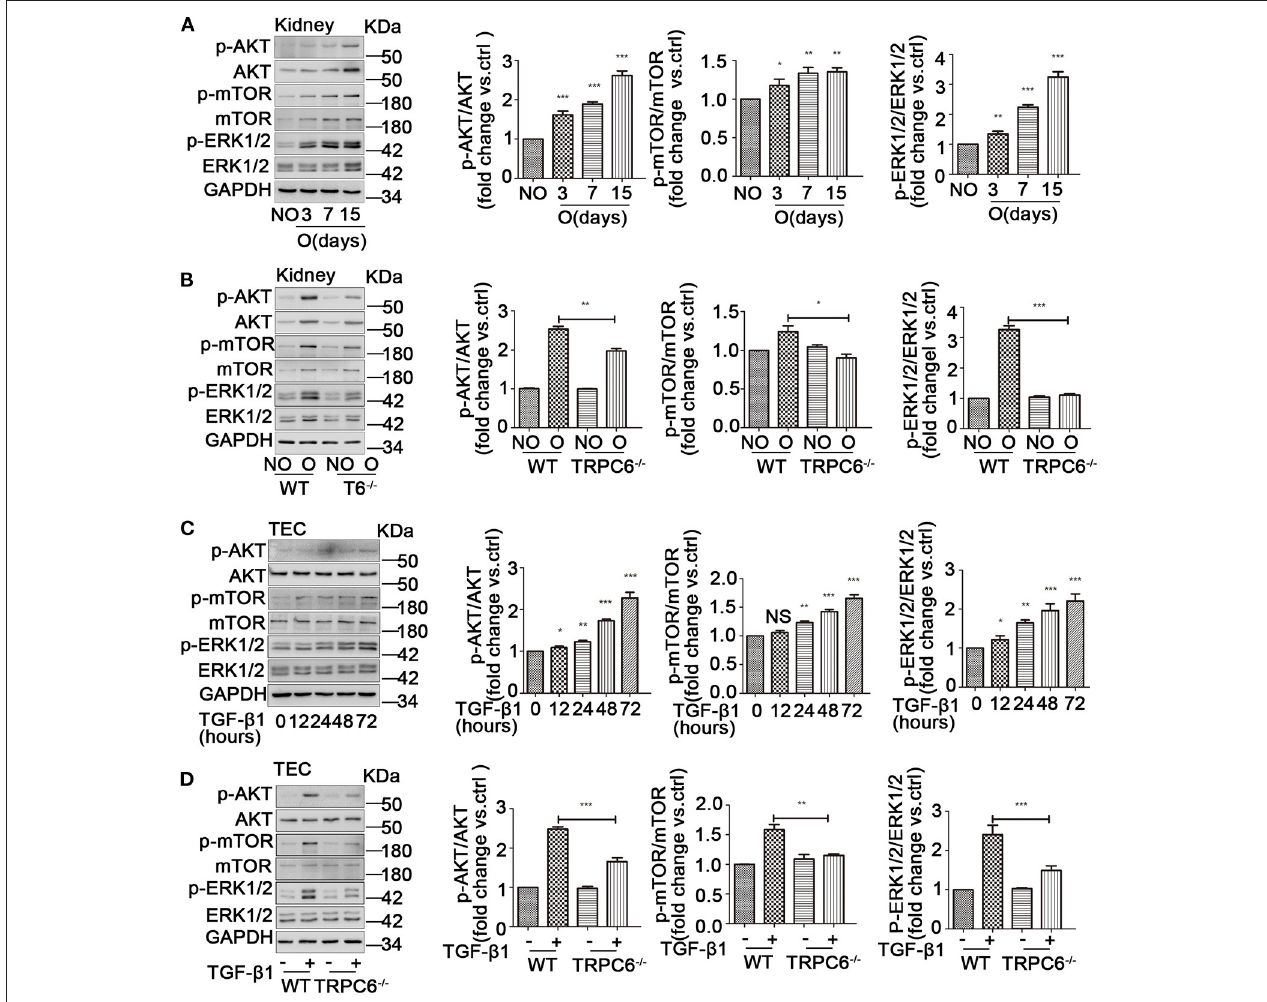
FIGURE 5 | The activation of AKT-mTOR and ERK1/2 signaling pathways was down-regulated in TRPC6 − / − mice. (A) Expression level of the phosphorylated and total protein of AKT, mTOR, and ERK1/2 in NO and O kidneys from WT mice on days 3, 7, and 15 after UUO detected by western blot. Data are presented as mean ± sem, n = 3; an unpaired two-tailed t -test was used. * P < 0.05, ** P < 0.01, *** P < 0.001. (B) Expression level of the phosphorylated and total protein of AKT, mTOR, and ERK1/2 in NO and O kidneys from TRPC6 − / − and WT mice on day 15 after UUO detected by western blot. Data are presented as mean ± sem, n = 3; an unpaired two-tailed t -test was used. * P < 0.05, ** P < 0.01, *** P < 0.001. (C) Expression level of the phosphorylated and total protein of AKT, mTOR, and ERK1/2 in primary TEC without and with TGF- β 1 stimulation at 12, 24, 48, and 72h detected by western blot. Data are presented as mean ± sem, n = 3; an unpaired two-tailed t -test was used. NS, not significant; * P < 0.05, ** P < 0.01, *** P < 0.001. (D) Expression level of the phosphorylated and total protein of AKT, mTOR, and ERK1/2 in primary TEC from WT and TRPC6 − / − mice with and without TGF- β 1 stimulation for 72h detected by western blot. Data are presented as mean ± sem, n = 3;